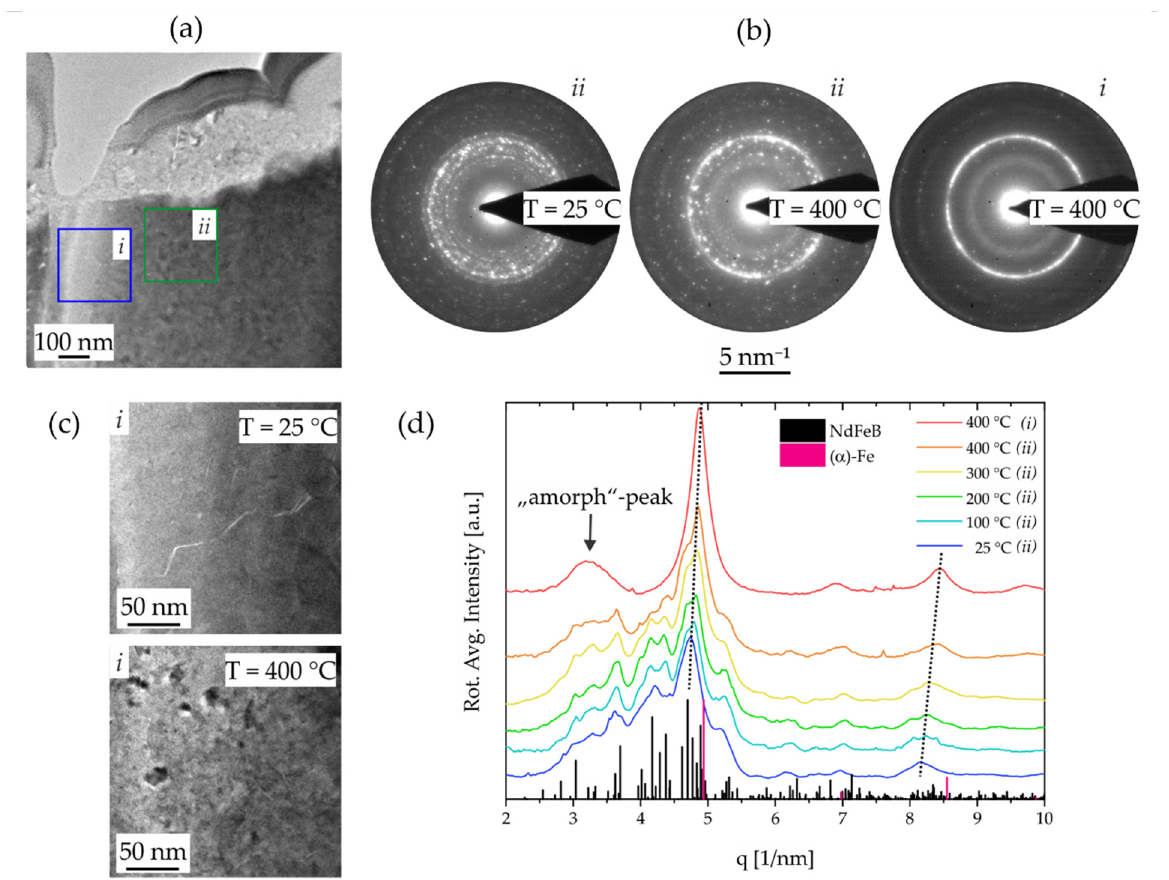
Figure 10. Investigation of the thermal degradation by an in-situ heating TEM experiment. ( a ) TEM image of the Al 2 O 3 -coated NdFeB particle showing two regions of different thickness produced by sample preparation: ( i ) thin region, ( ii ) thick region. ( b ) Exemplary SAED pattern of regions i and ii recorded at 25 °C and 400 °C. ( c ) TEM images of region I before heating and at 400 °C show the change in nanostructure upon thermal degradation. ( d ) Evolution of radially diffracted intensity (rotational averages) with temperature recorded on region ii . Diffracted data is compared to NdFeB and Fe reference data.